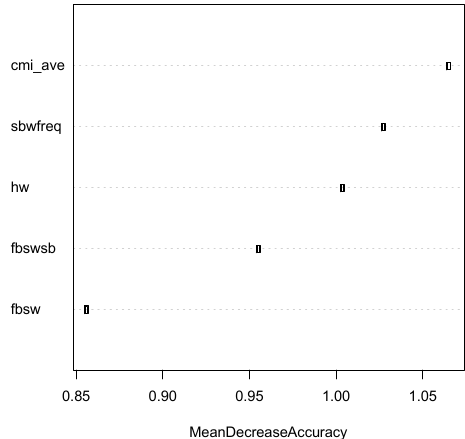
Figure 5. Importance of the explanatory variables used to construct the classification tree (Figure 3), as assessed by the randomForest procedure. These variables are the average climate moisture index (cmi_ave); the number of years of moderate–severe defoliation (sbwfreq); and the percentages of the total basal area, that is, hardwood (hw), balsam fir and white spruce combined (fbsw), or balsam fir, white spruce and black spruce combined (FbSwSb).